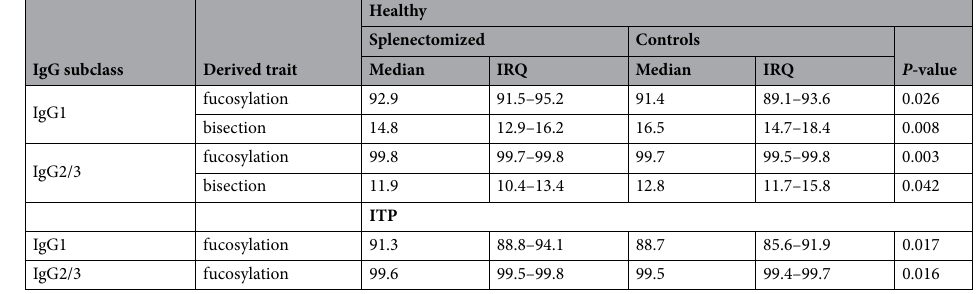
Table 2. Glycosylation comparison of two different patient groups (healthy and ITP) with splenectomy and age- and sex-matched respective controls with an intact spleen. P -values are given for a Wilcoxon-rank sum test. Only significant differences in IgG-Fc glycosylation ( P < 0.05) are shown.